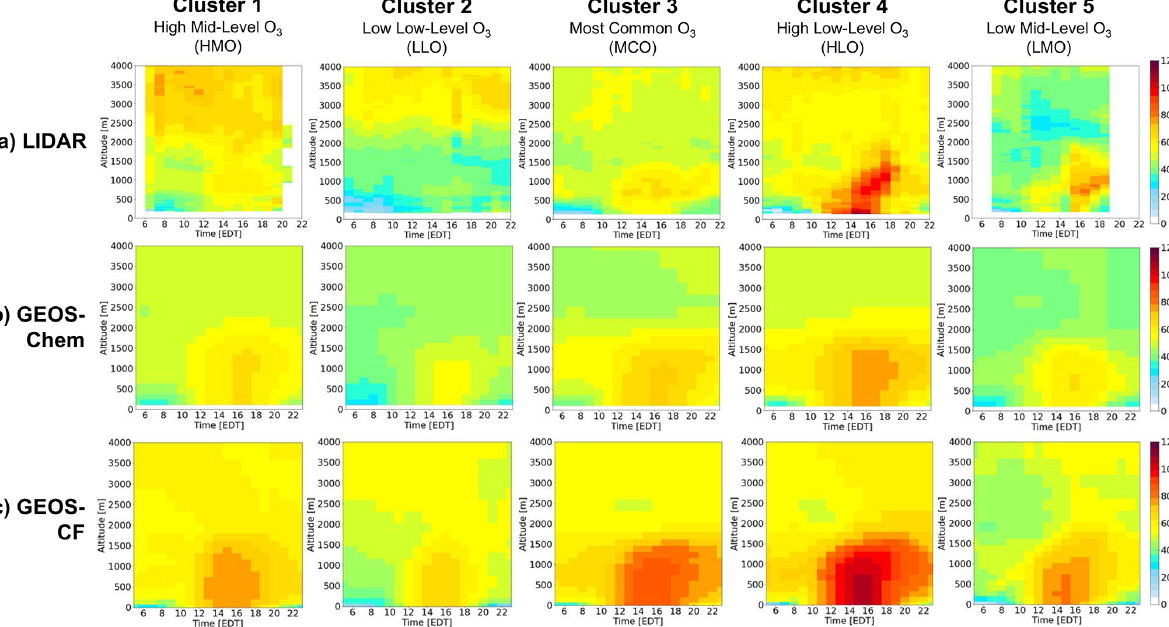
Figure 4. Cluster mean O 3 vertical profile results by cluster assignment (1–5) and arranged as follows: (a) lidar; (b) GEOS-Chem simulation; and (c) GEOS-CF simulation.